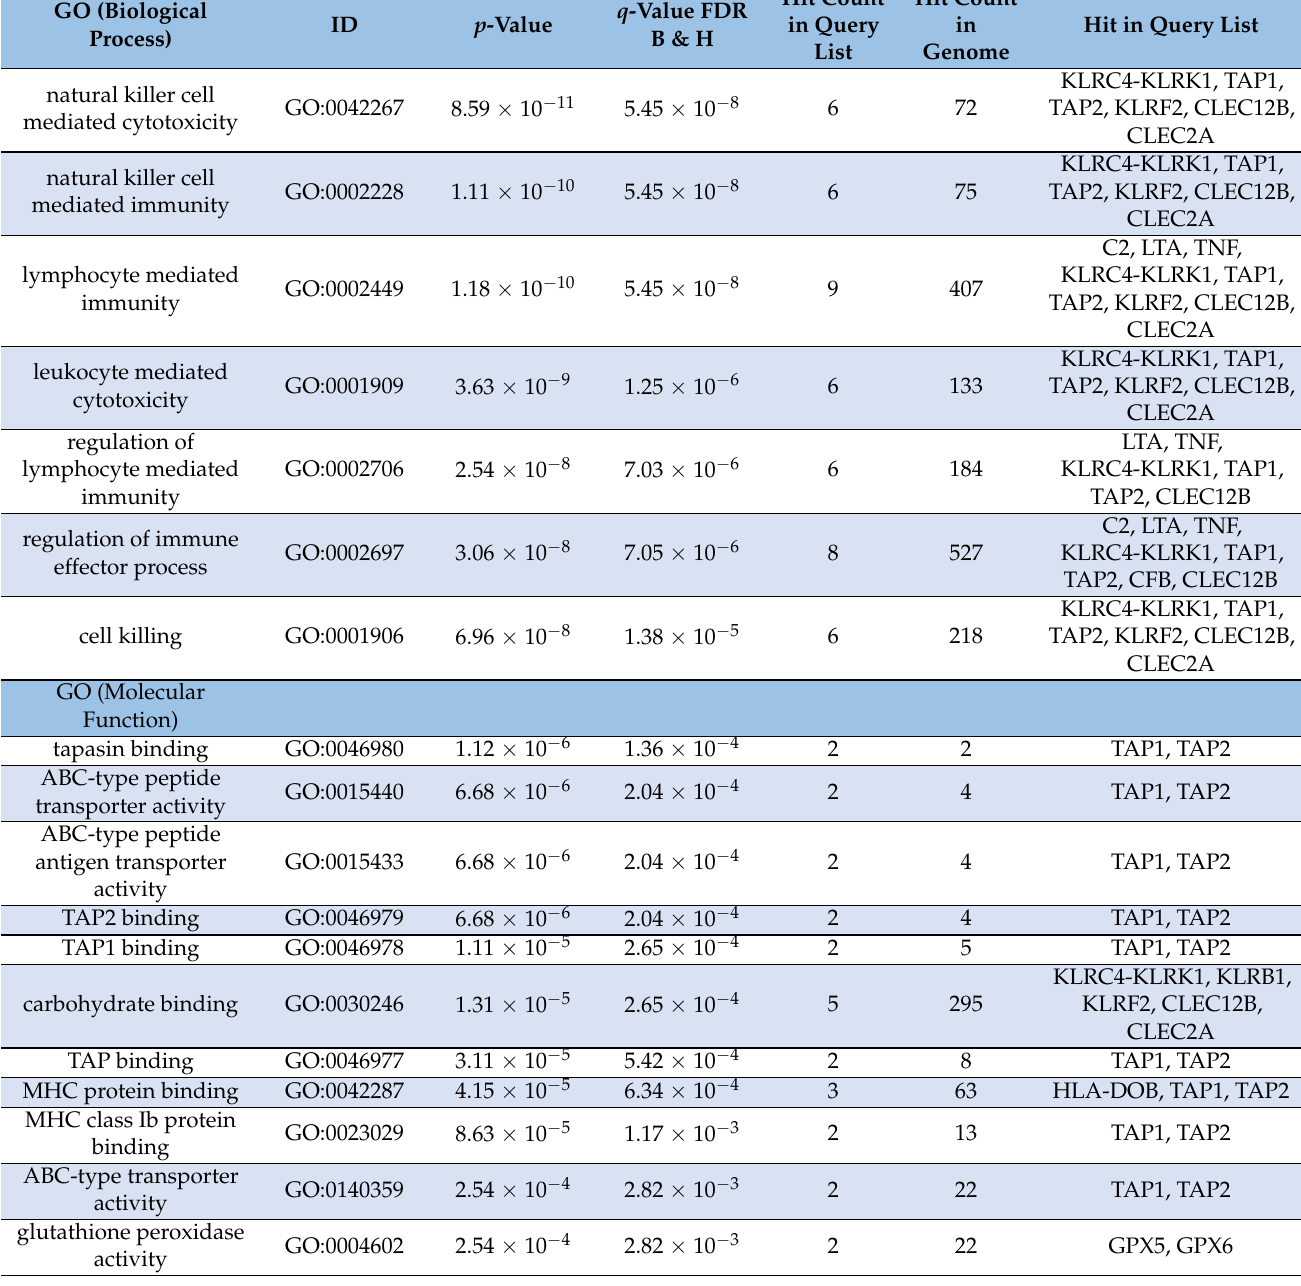
Table 5. Top hits from the functional Enrichment analysis by ToppGENE using the identified genes in the overlapping analysis (Table 3) and passing FDR (adjusted p < 0.05). The top five biological processes identified all belong to the same lineage of pathways, with leukocyte mediated immunity being a parent pathway of natural killer cell mediated cytotoxicity (numbered 1 to 4). See ssupplementary files ‘additional file S1’ for full